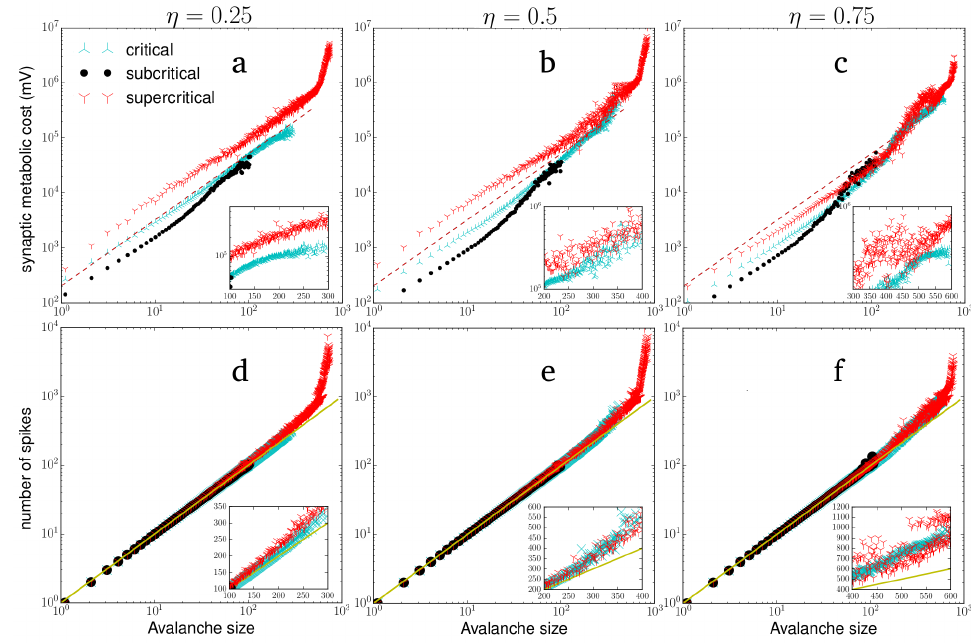
Figure 5. Metabolic cost of dynamic regimes. Top: synaptic cost, down: number of spikes. We show three excitation populations: η = 0.25 ( a , d ), η = 0.5 ( b , e ), and η = 0.75 ( c , f ). For synaptic cost ( a – c ), a power-law function with exponent β = 1.2 is shown. For number of spikes ( d – f ), a linear relation is shown as a solid line: number of spikes equal to avalanche size.